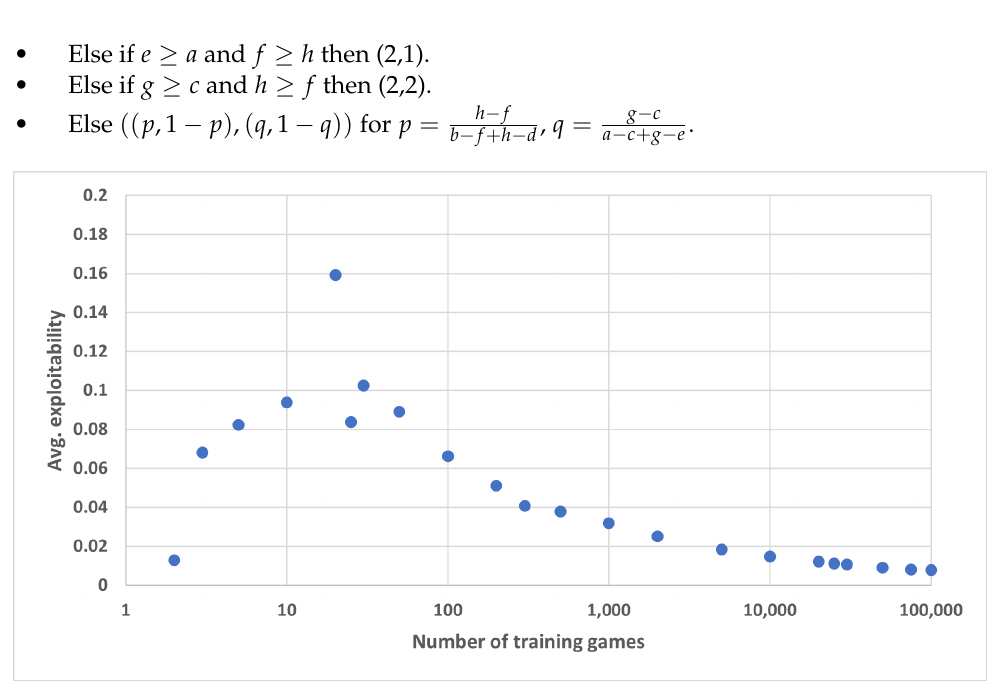
Figure 1. Exploitability vs. number of training games for two-player zero-sum games with uniform- random payoffs in [ − 1,1], with results averaged over 10,000 test games for each number of train- ing